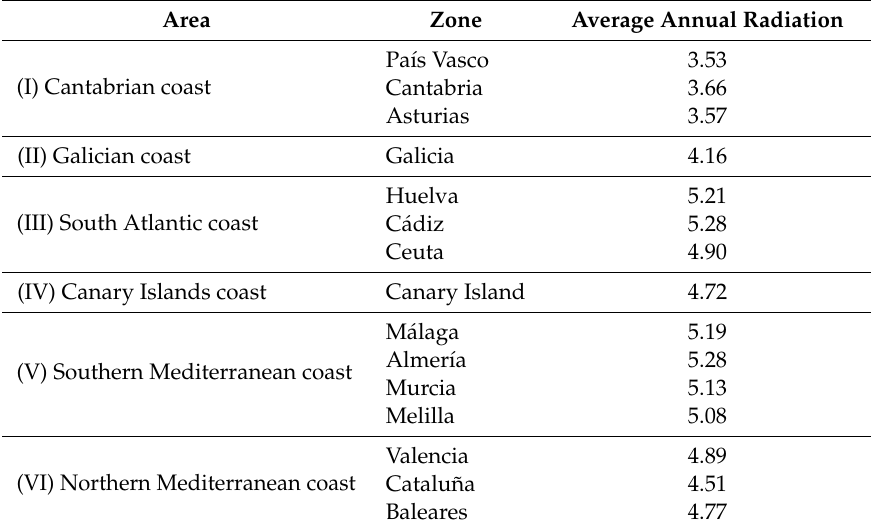
Table 7. Radiation solar values, in kWh / m 2 day in all the areas in the Spanish coast. Area